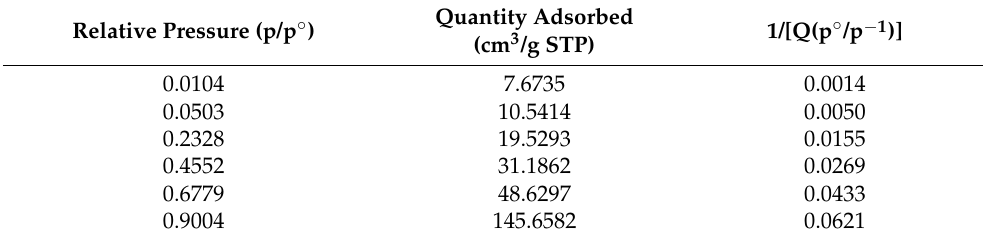
Table 1. BET isotherm tabular report for N 2 adsorption over the surface of Fe 3 O 4 NHS at evacuation rate of 1000.0 mmHg/min and saturation pressure of 760.0 (mmHg).